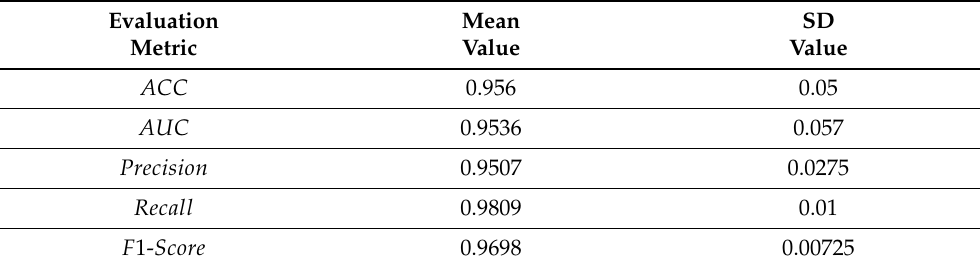
Table 6. The mean and SD values of ACC , AUC , Precision , Recall , and F 1- Score obtained with the set of best symbolic expressions on the original